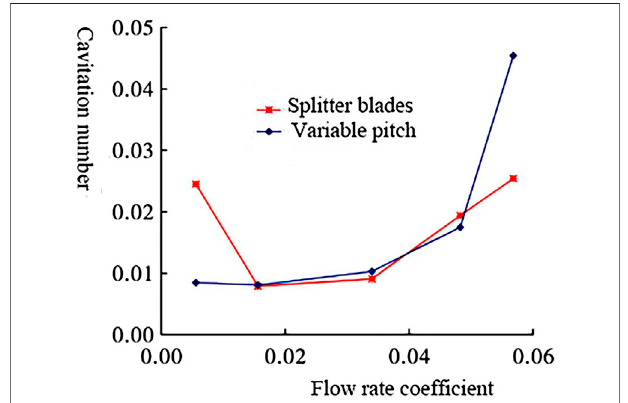
FIGURE 4 | Curves of NPSH with the fl ow coef fi cient (Xilong Huang, 2020).